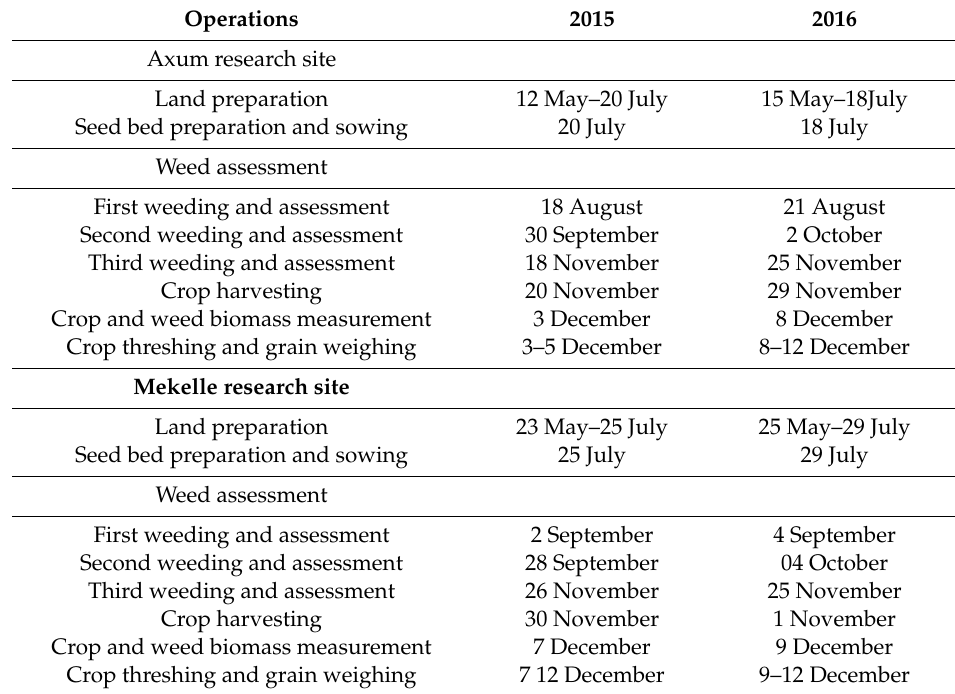
Description of crop and weed management and assessment operations in the two experimental